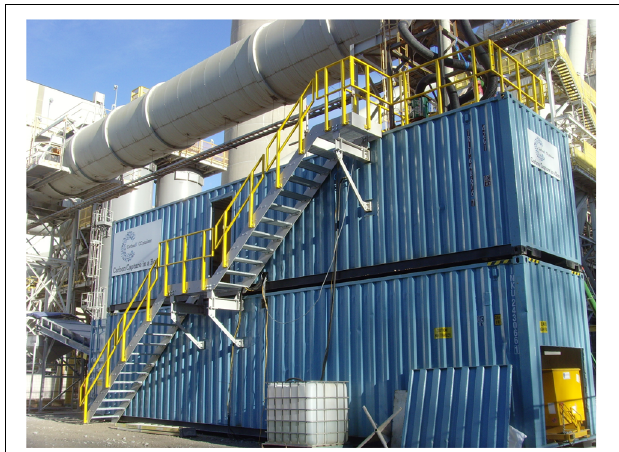
FIGURE 5 | General framework for life cycle assessment (ISO 14040,